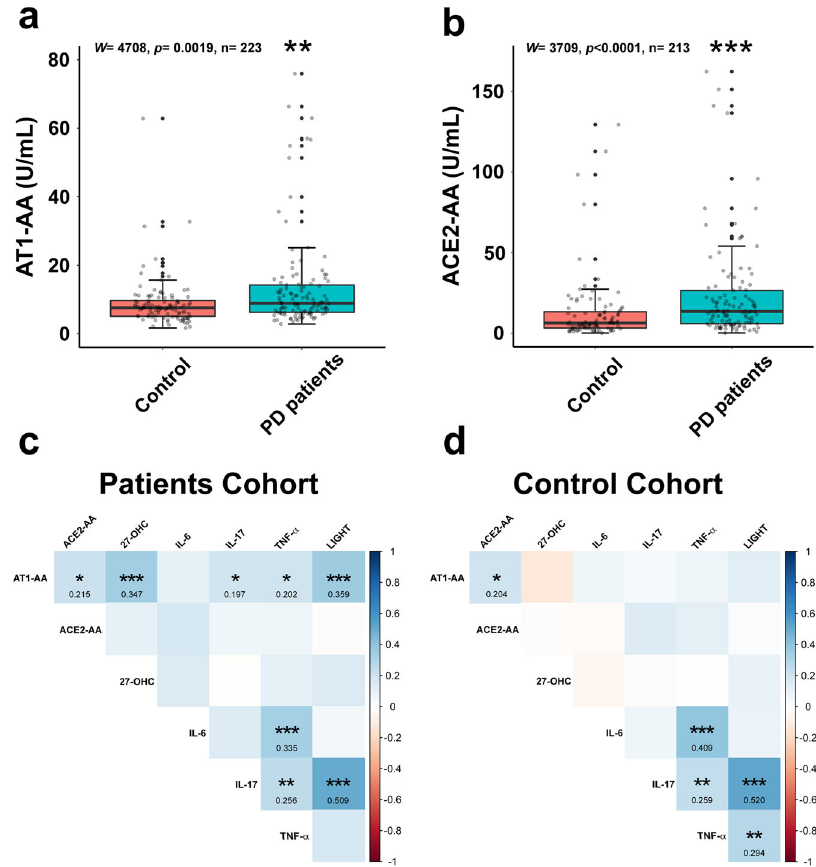
Fig. 1 Autoantibody serum levels and their correlations with in fl ammatory cytokines and 27-hydroxycholesterol in controls and PD patients. Parkinson´s disease (PD) patients had signi fi cantly higher serum levels of AT1-AA ( a ; Wilcoxon test, W = 4708, P = 0.0019) and ACE2- AA ( b ; Wilcoxon test, W = 3709; P < 0.0001) than controls. Results of Spearman ’ s correlation matrix show variables (AT1-AA, ACE2-AA, 27-OHC, cytokines) correlating at varying levels of signi fi cance (* P < 0.05; ** P < 0.01; *** P < 0.001) in PD patients ( c ) and controls ( d ). In a and b , data distribution is shown using a box plot with boxes representing the IQR and the median (black line) and whiskers representing ± 1.5 IQR. IQR Interquartile range. ** P < 0.01; *** P < 0.001. 27-OHC, 27-Hydroxycholesterol; AT1-AA: Autoantibodies for AT1 receptors; ACE2-AA: ACE2